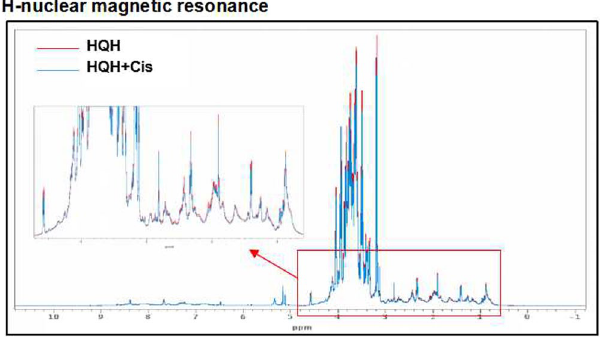
Figure 4. HQH does not bind with cisplatin. ( A ) The nuclear magnetic resonance showed that HQH and Cis does not interact with each other. The red line indicates the hydrogen spectra of HQH. The blue line indicates the hydrogen spectra of which Cis into HQH. These two lines substantially overlapped, suggesting that HQH does not interact with Cis. (nuclear magnetic resonance spectrometer, agilent 600